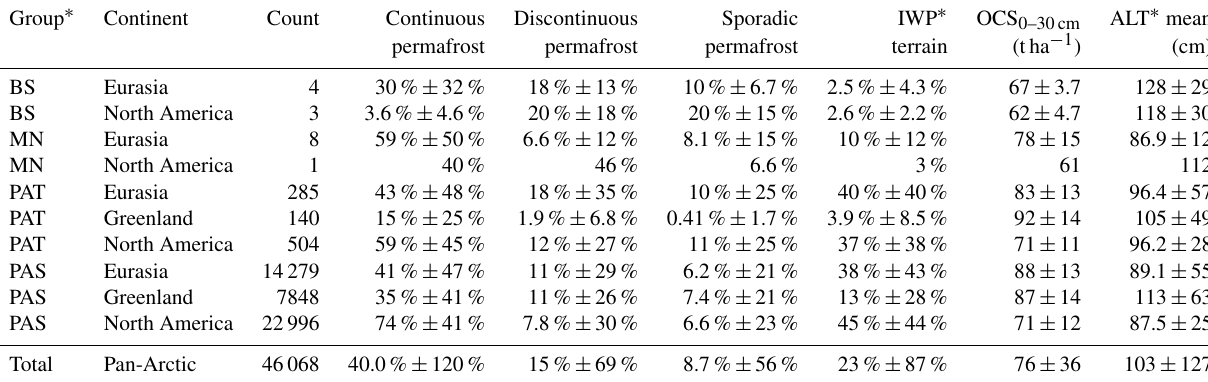
∗ Abbreviations stand for the grouped watersheds by area: Big Seven (BS), Middle Nine (MN), Pan-Arctic Thousands (PAT), Pan-Arctic Small watersheds (PAS); “count” represents the number of catchments covered by the subsequent data columns; IWP stands for “ice wedge polygon”; OCS 0–30cm stands for “organic carbon stock” in the upper 0–30cm of the soil; ALT stands for “active-layer